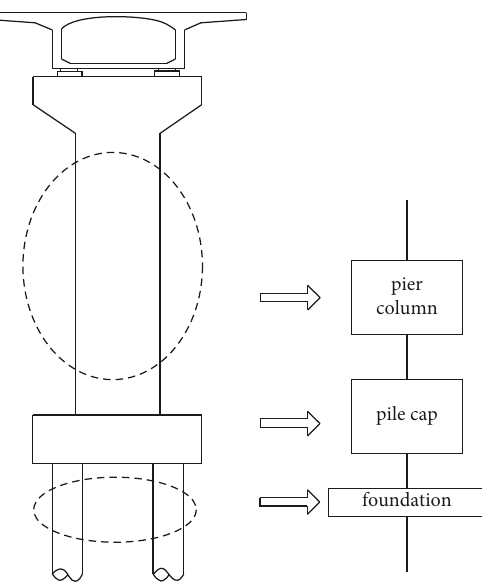
Figure 5: Schematic diagram of bridge pier structural